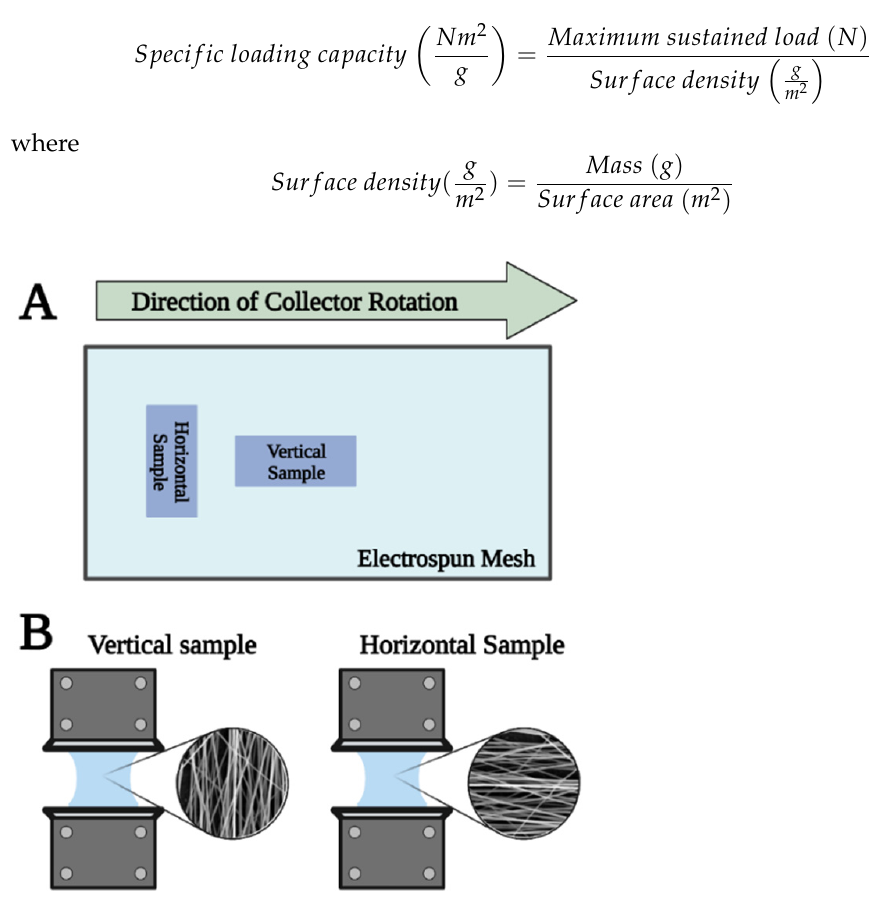
Figure 3. Cutting of samples for mechanical evaluation ( A ) and fibre orientation differences ( B ) in the case of monolayer membranes.